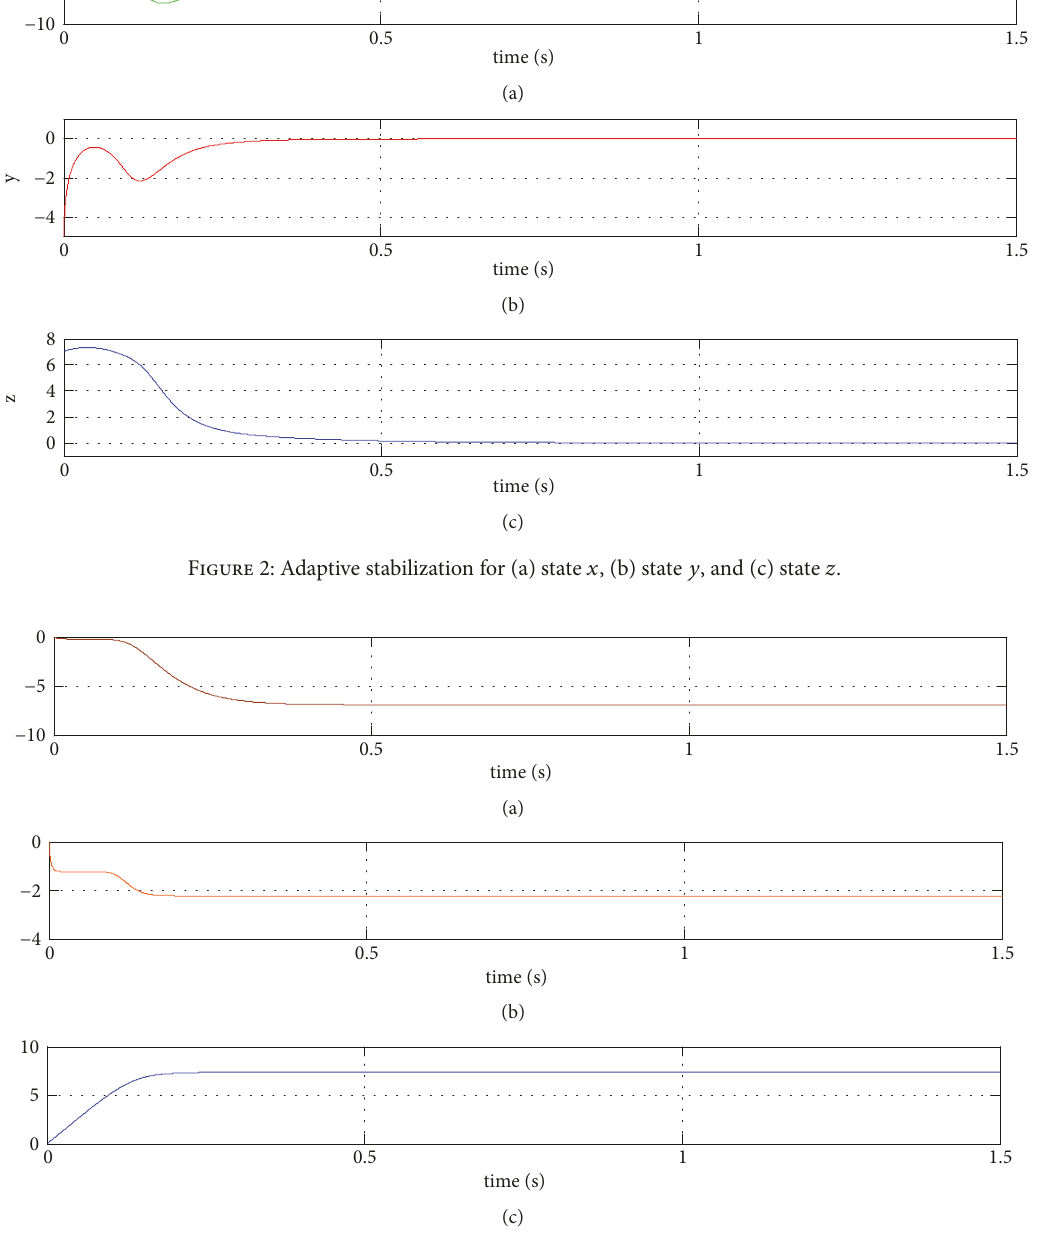
Figure 3: Estimations of the unknown parameters: (a) ̂𝑎 , (b) ̂𝑐 , and (c)